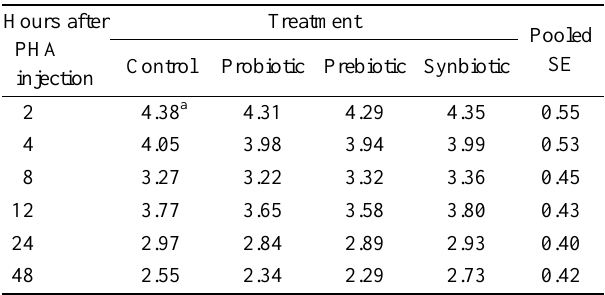
Table 6. Effect of probiotic, prebiotic and synbiotic on skinfold response to intradermal injection of